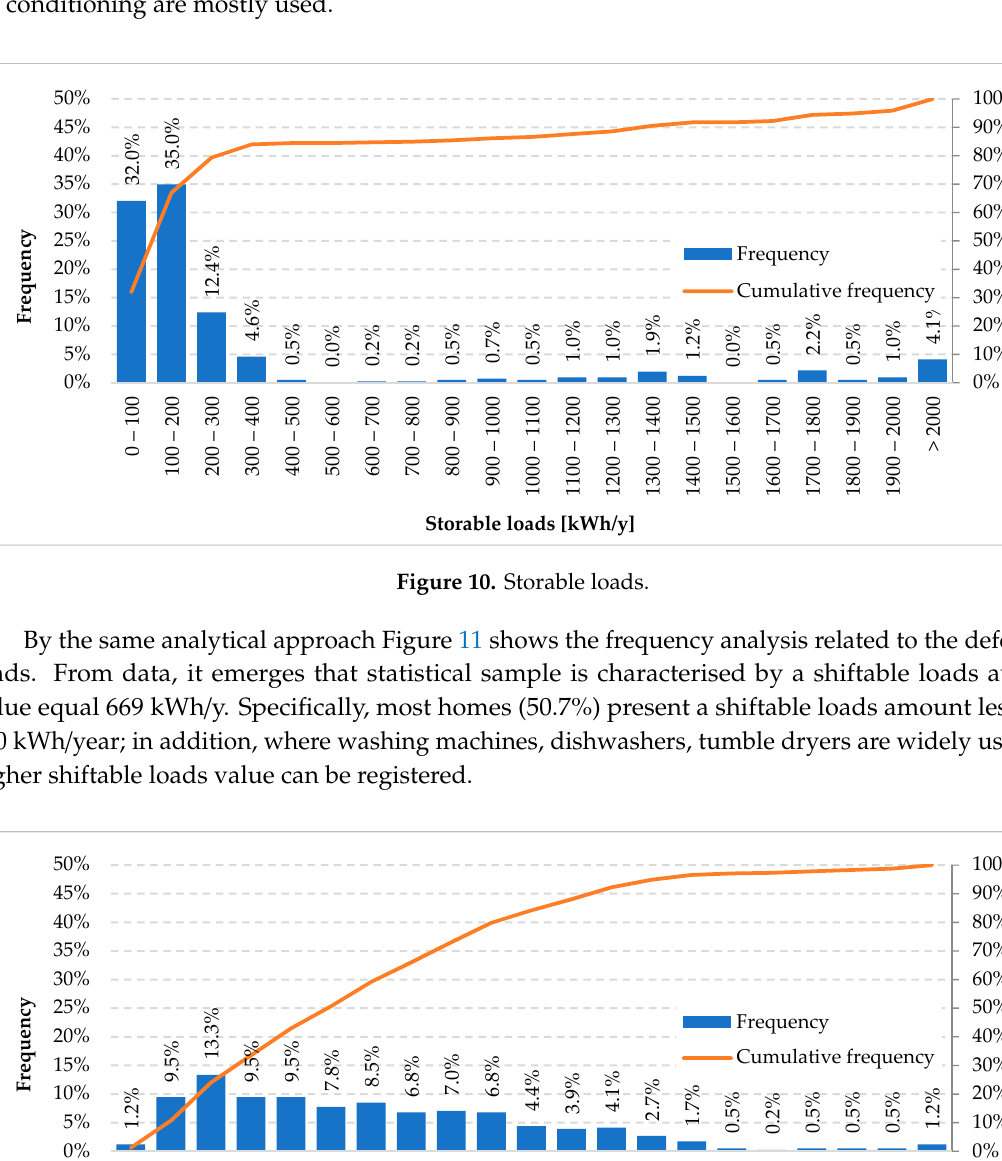
Figure 11. Shiftable loads.